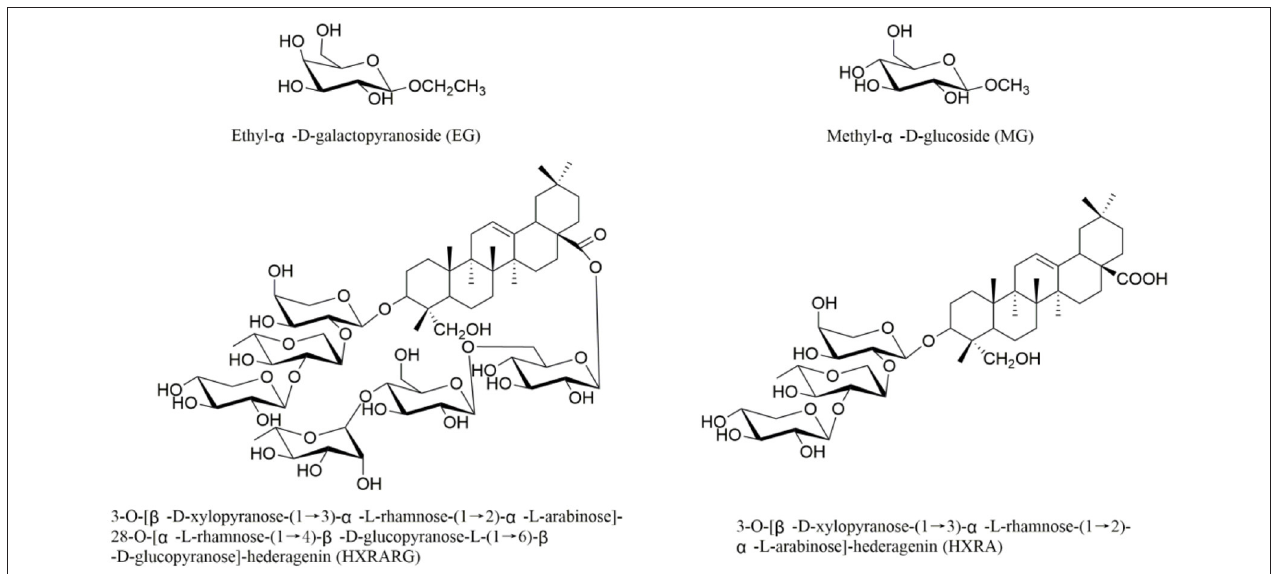
FIGURE 1 | Structures of compounds EG, MG, HXRARG, and HXRA from Nigella sativa .